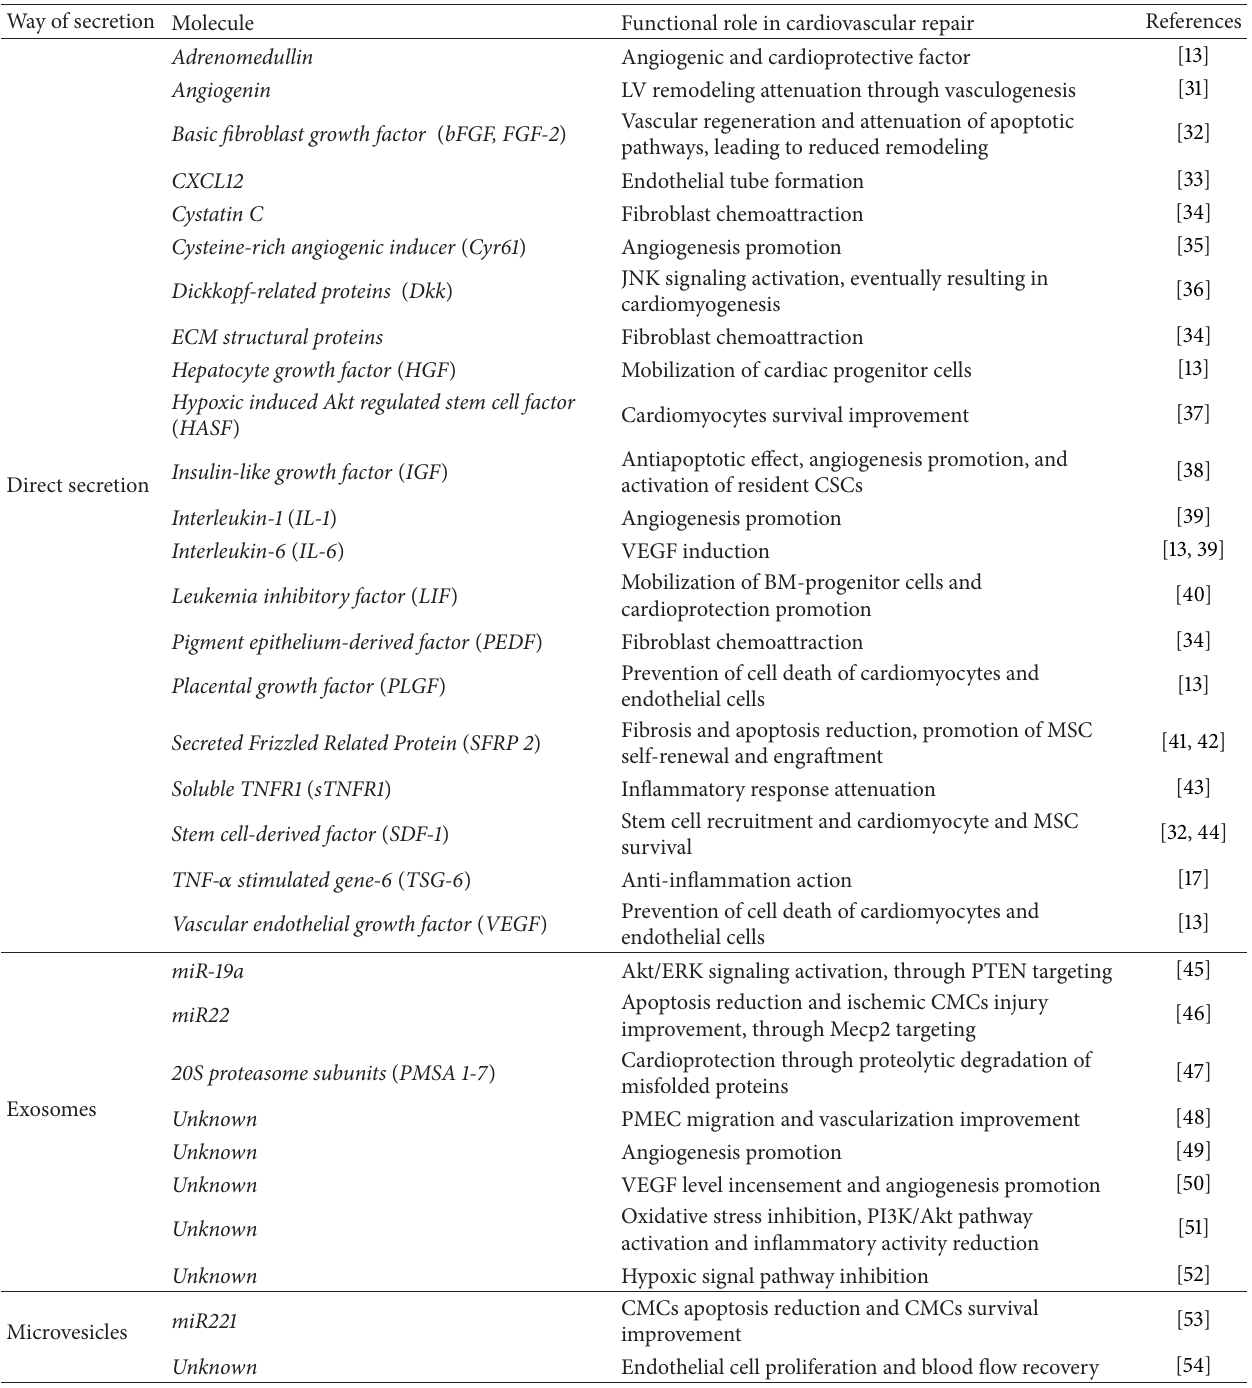
Table 1: Summary of molecules released by MSCs, via either direct secretion or exosomes and microvesicles, and their diverse beneficial effects in cardiovascular repair. The table includes relevant studies demonstrating specific molecule expression/secretion by MSCs and their respective